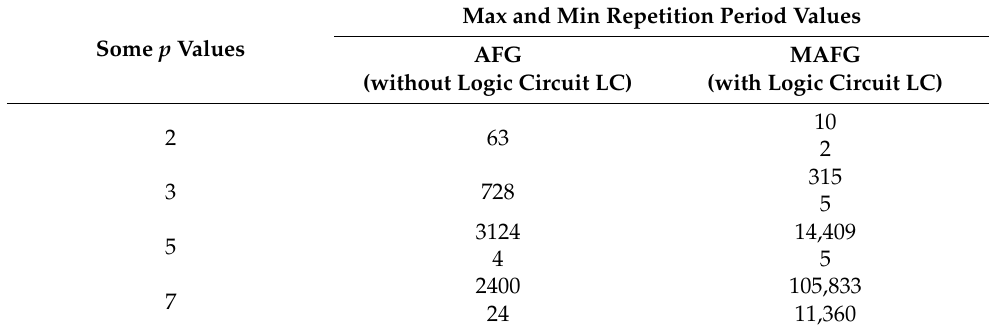
Table 1. Repetition periods of AFG and MAFG output sequences for p value on the whole set of possible values, X (0) = 0 ÷ p 6 −